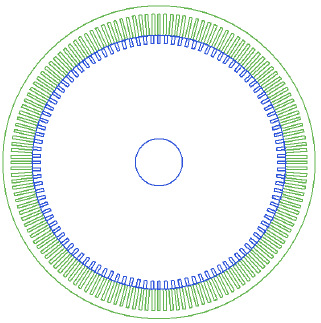
Figure 7. Parameters of a stator slot and a rotor slot. ( a ) Stator Slot dimensions. ( b ) Rotor Slot di- mensions. Figure 8. Ansys RMxprt model of medium voltage machine.